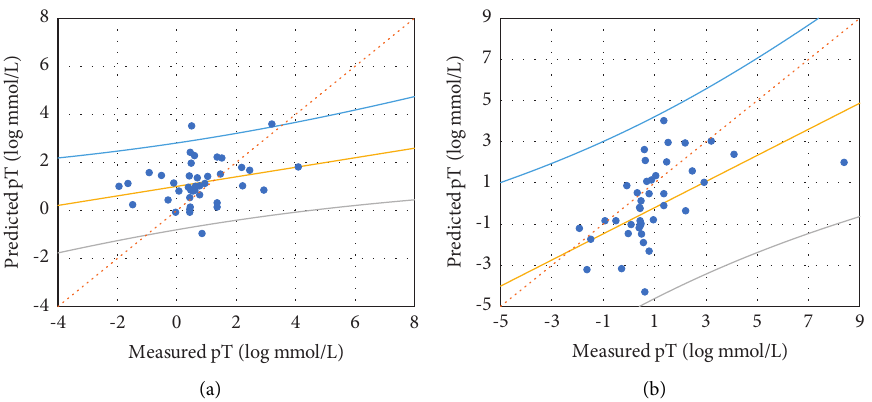
Figure 2: QSAR model predictions versus measured toxicity. The best-fit linear regression and 95% prediction intervals are shown. (a) Tugcu’s model. (b)